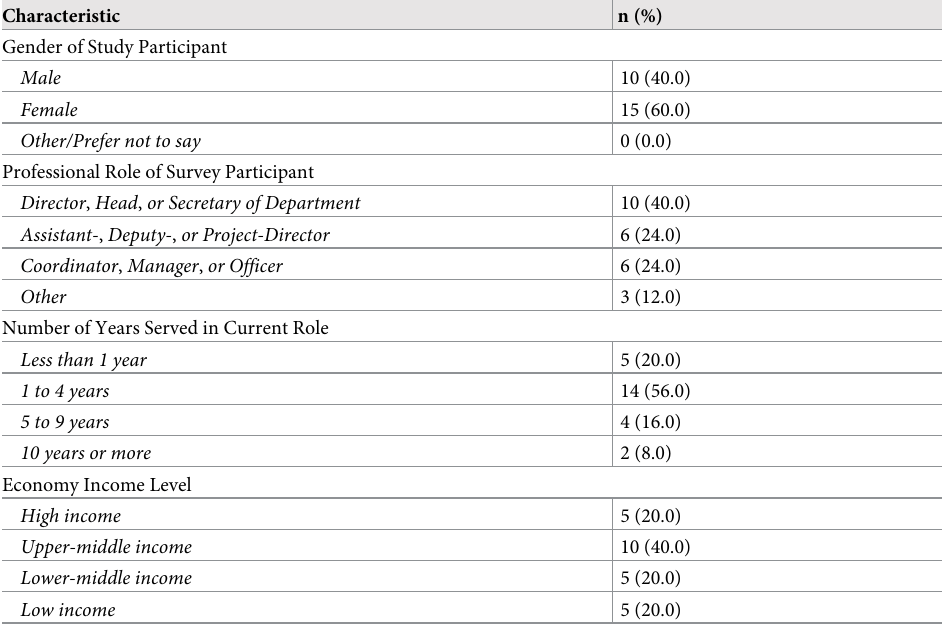
Table 1. Characteristics of study participants and cities (n =